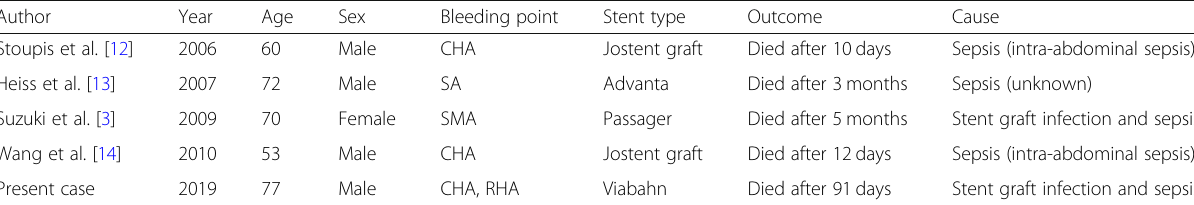
Table 1 Cases of stent graft infection or sepsis following stent graft placement for visceral hemorrhage after